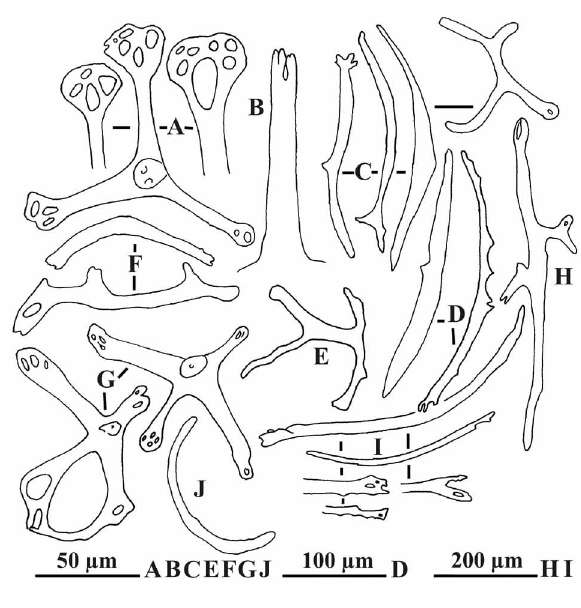
Fig . 3. – Synallactes virgulasolida n. sp. A, cross-shaped ossicles from dorsal papillae (holotype); B, central pillar of a cross-shaped ossicles from dorsal papillae (holotype); C, rods from dorsal pa- pillae (holotype); D, E, F, H, rods of the tentacles (holotype); G, cross-shaped ossicles from the tentacles (holotype); I, J, rods of the tentacles (paratype Fig . 2. – Synallactes virgulasolida n. sp. A, calcareous ring paratype (r: radial piece; ir: interradial piece); B, tables of ventral body wall (holotype); C, table from ventral body wall, lateral view (holotype); D, cross-shaped ossicles from dorsal body wall (holotype); E, bean-shaped ossicles from ventral tube feet (holotype); F, massive rods of the ventral tube feet (holotype); G, club-shaped ossicles from ventral tube feet (holotype); H, slender rods from the ventral tube feet (holotype); I, cross-shaped ossicles from ventral tube feet (holotype); J, massive rods from ventral tube feet (paratype 1); K, slender rods from ventral tube feet (paratype 1); L, massive rods from ventral tube feet (paratype 2).